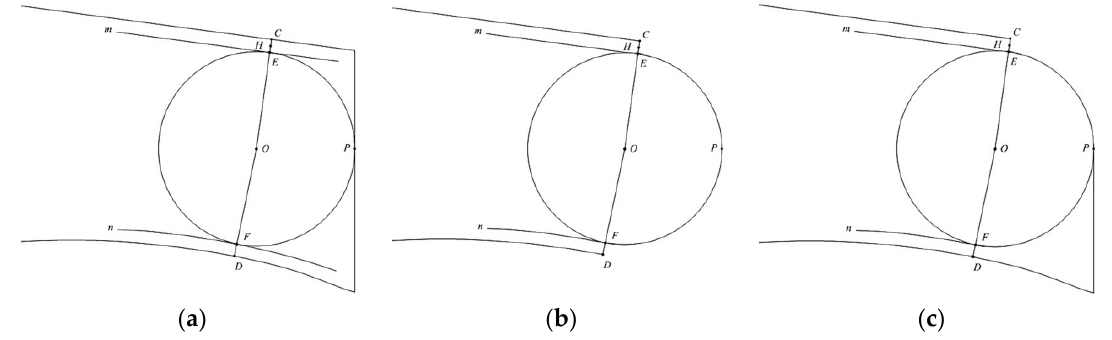
Figure 2. Details of the blunt trailing edge design: ( a ) DU97-Flatback; ( b ) DU97-Flatback-FCC (Full Circulation Control); ( c ) DU97-Flatback-PCC (Partial Circulation Control).